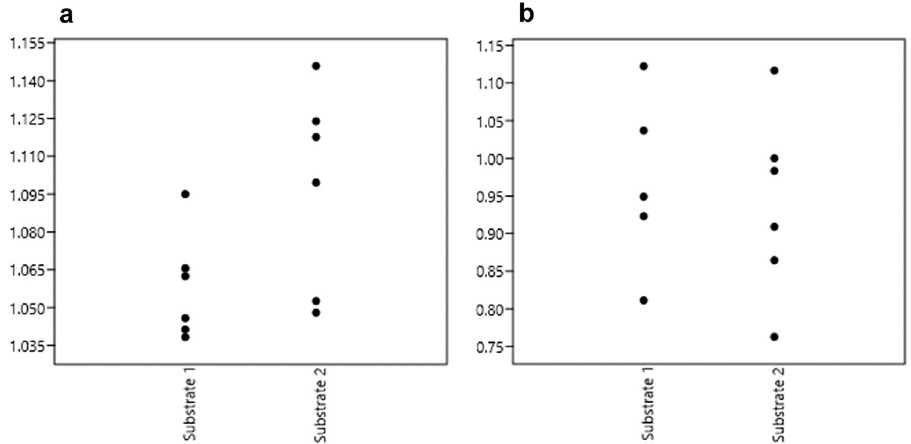
Figure 5. Jitter plots of ratios computed on footprints. ( a ) Ratio between the length of footwear prints and barefoot prints for the two substrate types; ( b ) ratio between the width of the proximal part of footwear prints and barefoot prints for the two substrate types.